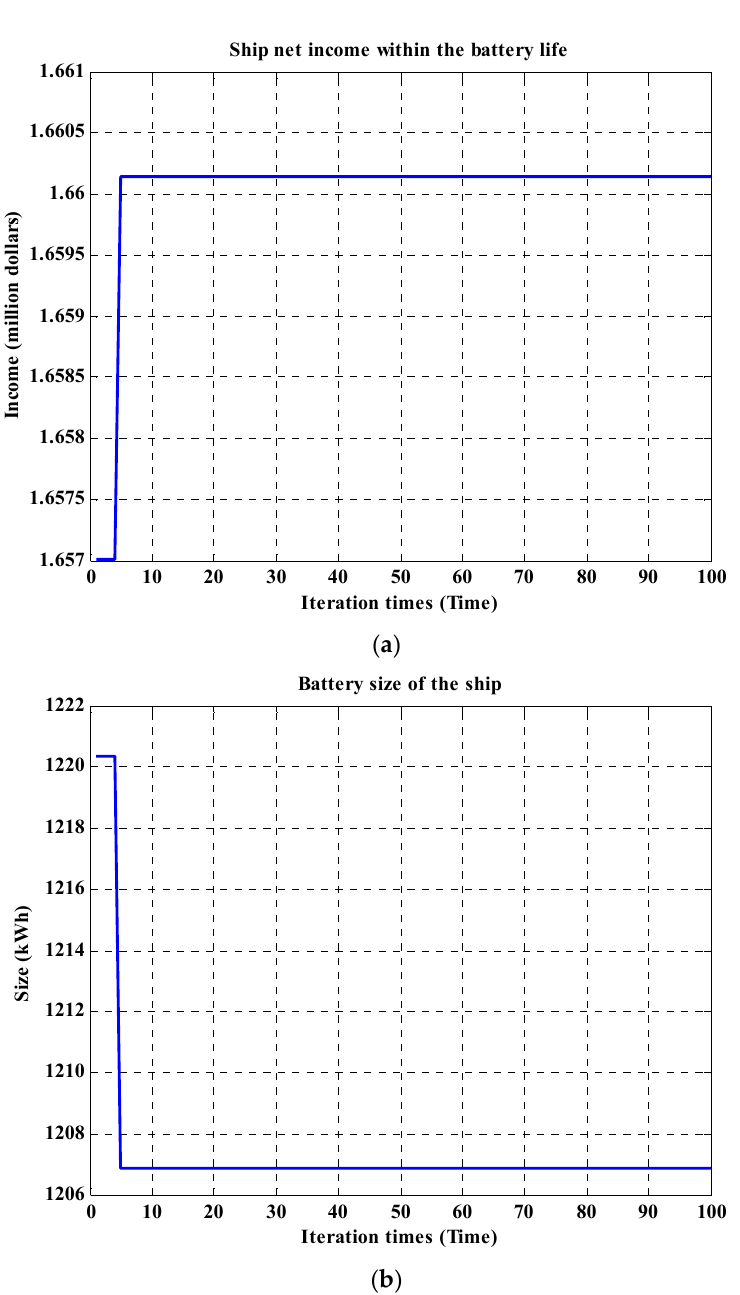
Figure 12. Simulation results of scenario 2 in case 2. ( a ) Variation of ship net income within the battery life over the optimization procedure ( b ) Battery capacity variation over the optimization procedure